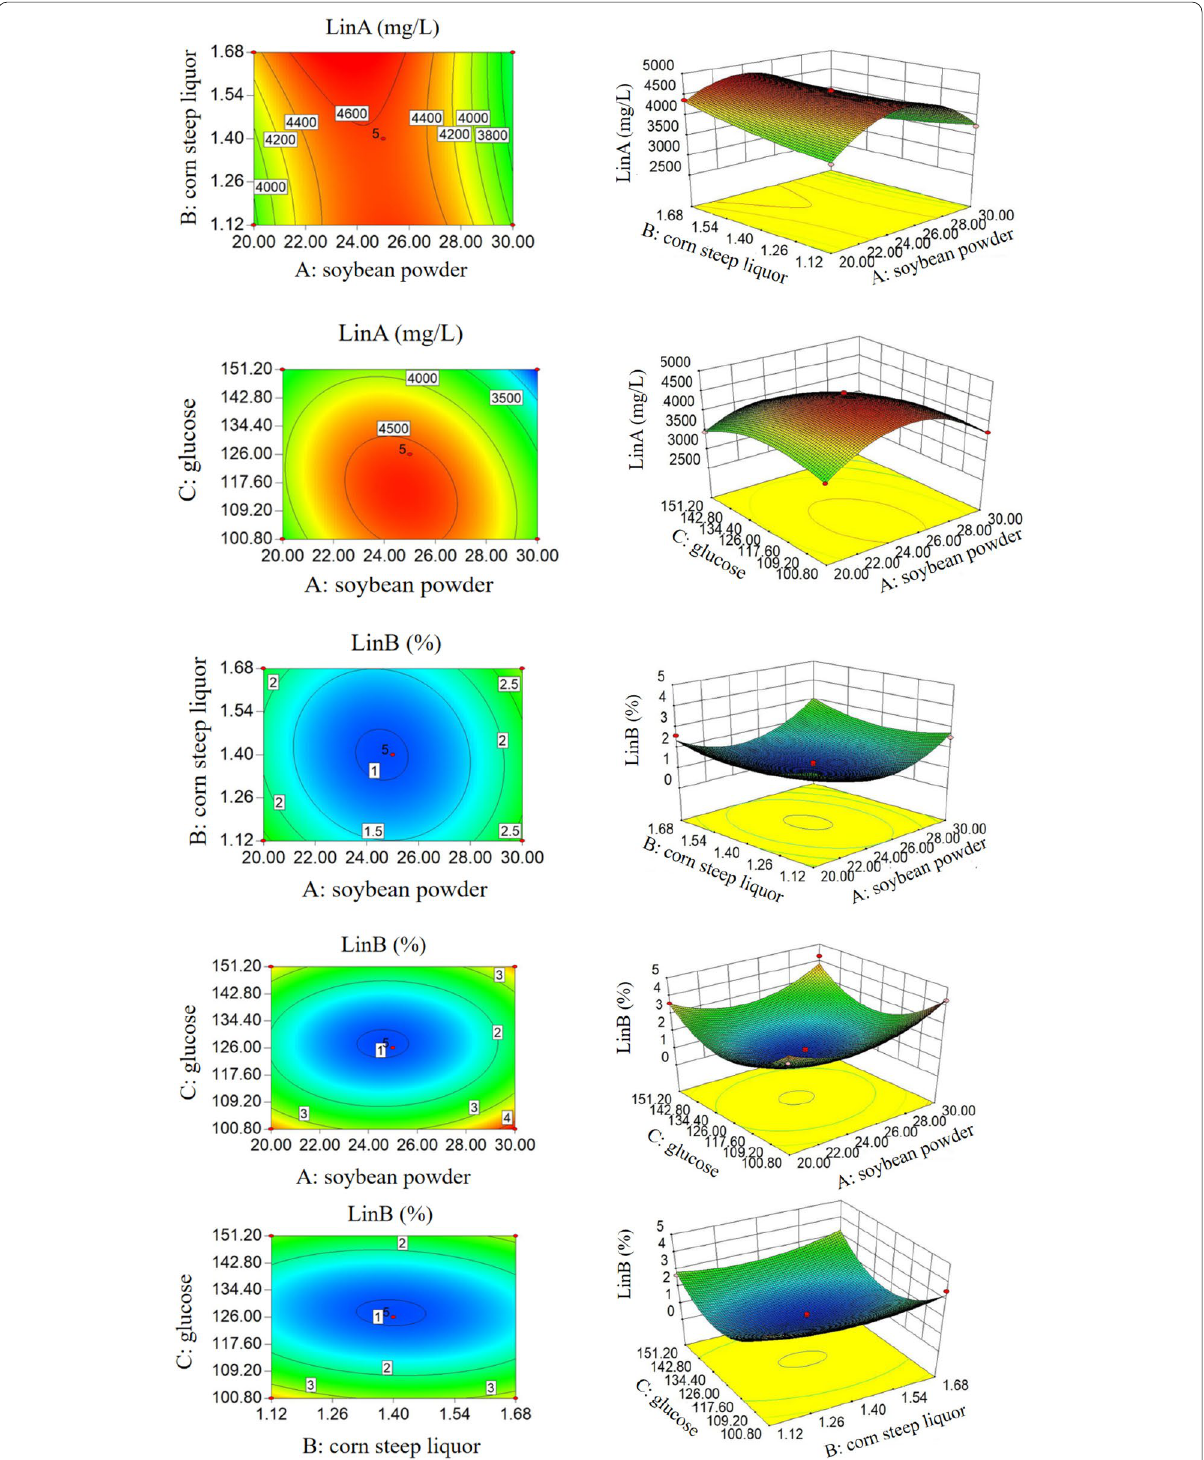
Fig. 1 Contour (left) and response surface (right) plots of the effects of soybean powder, corn steep liquor, and glucose on lincomycin A ( A ) and lincomycin B ( B )